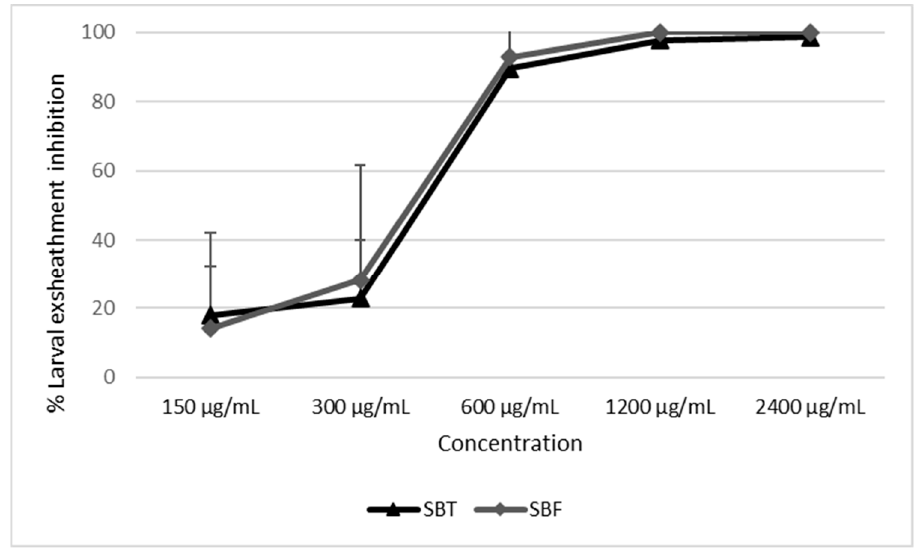
buckthorn juices from Tuscany, Italy (SBT) and Friuli-Venezia Giulia, Italy (SBF).